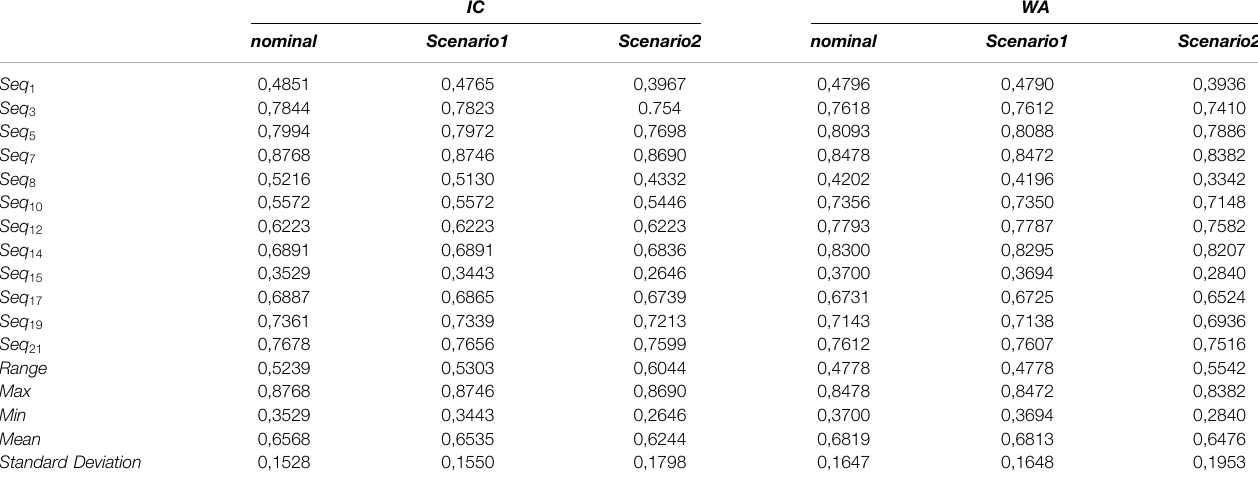
TABLE 11 | Scores and ranking for both operators, CI and WA, for the three scenarios, i.e., nominal, #1 and #2, for the sequence including route 1. IC WA nominal Scenario1 Scenario2 nominal